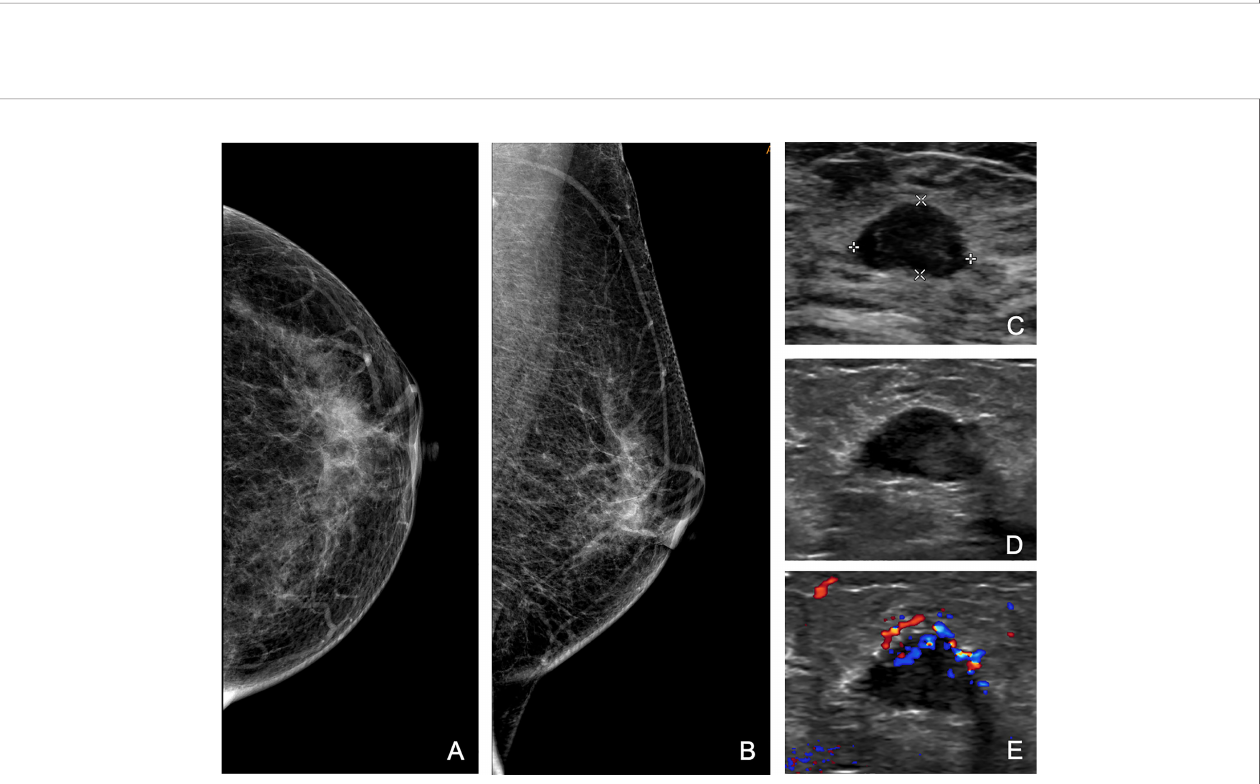
FIGURE 3 | A 65-year-old woman was referred to our hospital for a category 4b mass on the right breast, and the second US found a new 4b mass on the left breast, which was categorized as 3 at the initial assessment. Craniocaudal (A) and mediolateral oblique (B) mammograms of left breast, and initial US (C) of the left mass. (D, E) Second US showing a hypoechoic mass with micro-lobulated margin and enriched vascularity on the axial view. Subsequent biopsy revealed in fi ltrative ductal